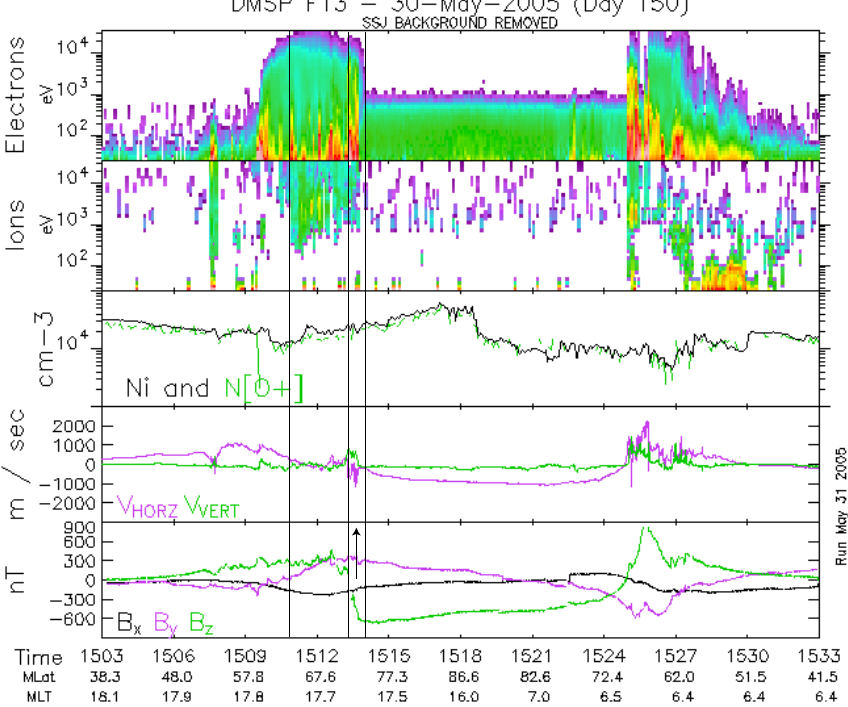
Fig. 7. DMSP F13 data obtained during the pass from dusk to dawn in the interval 15:03–15:33UT on 30 May 2005. Same format as in Fig.